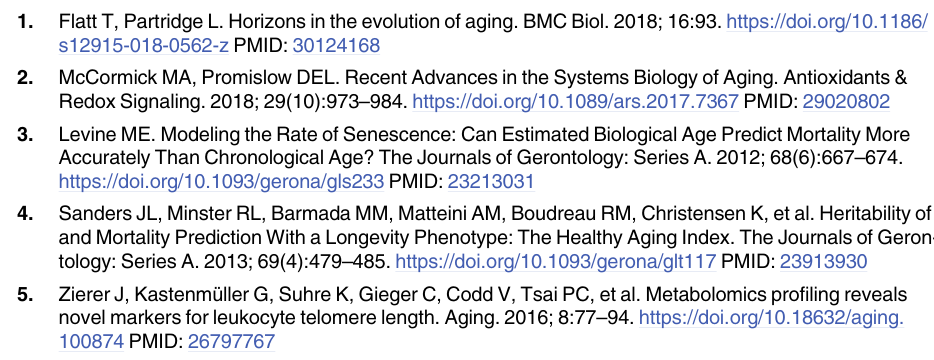
S11 Table. Signed logarithm of the bonferroni-corrected p -values for the A-type interac- tions shown in Fig 12 (comma-separated values). S12 Table. Signed logarithm of the holm-bonferroni-corrected p -values for the A-type interactions shown in Fig 12 (comma-separated